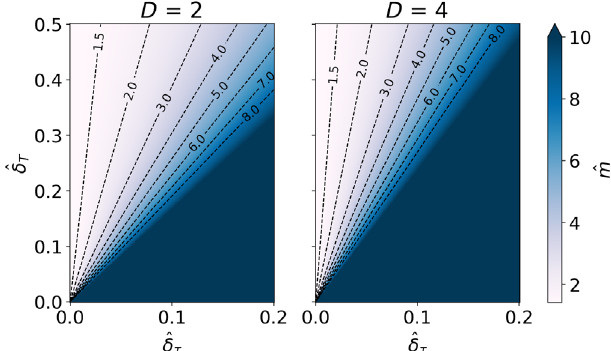
FIG. 8. Relationship between the normalized safety margin ˆ m ˆ δ ˆ δ Þ for parameter space dimension D ¼ 2 (left) and D ¼ and ð τ ; T 4 (right). As it can be seen here, given the same ˆ δ requires a larger safety margin in order for RCDS-S to follow the trend of the drift.